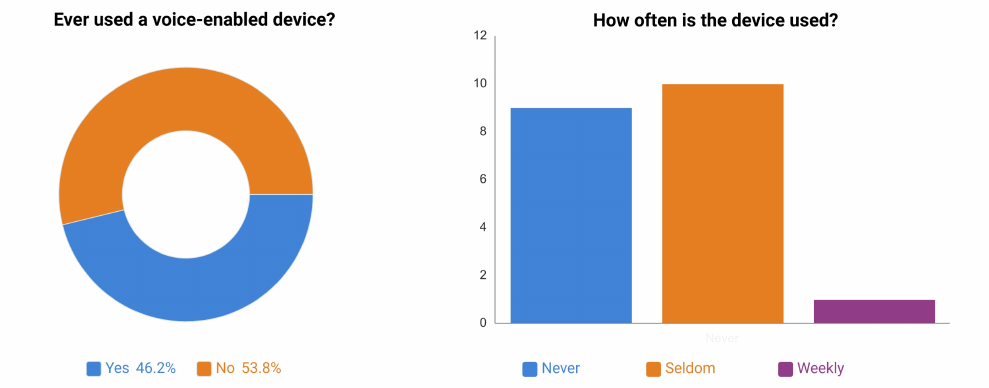
Figure 9. Statistical data deviated from initial survey (Source: own authors’